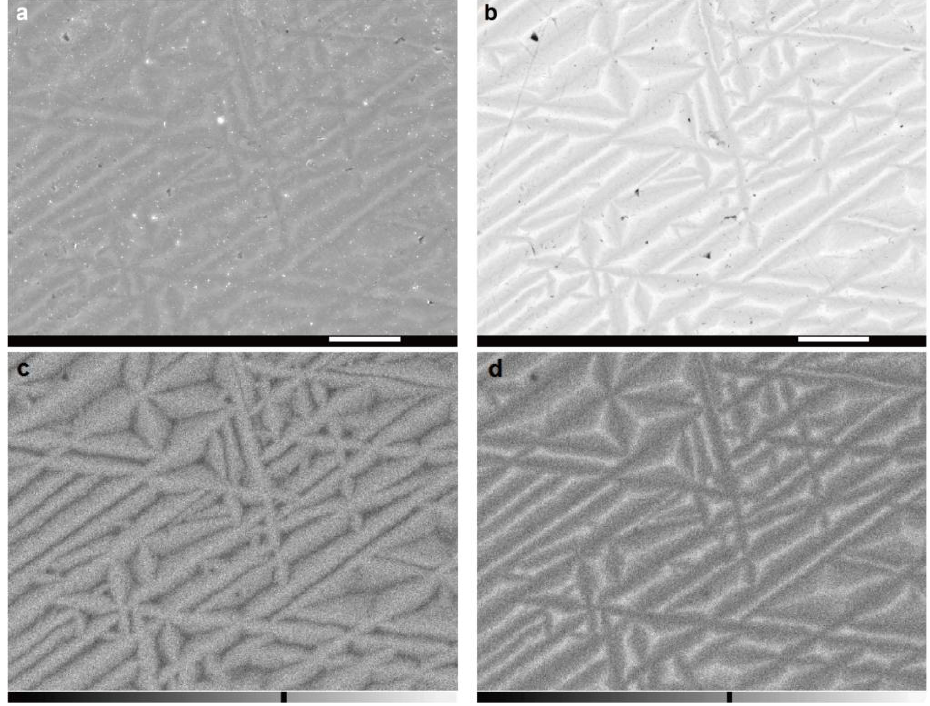
Figure 7. Cross-sectional ( a ) secondary-electron and ( b ) back-scattered-electron SEM images of the annealed f-TiZr alloy along with the scale bars with 10 μm in length. ( c ) Ti and ( d ) Zr concentration maps of the annealed f-TiZr alloy obtained by EDS along with intensity scale bars (below each image where the left-end color shows no intensity) and averaged intensity (black line in each bar). All these images have identical spacial scale to that of Figure